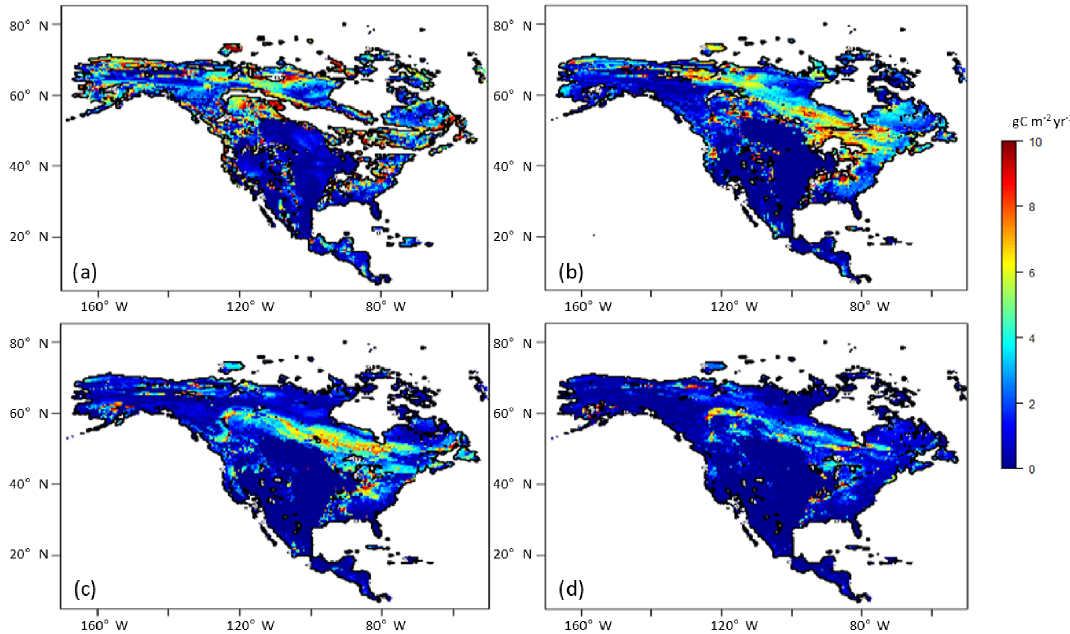
Figure 3. Simulated NEP (gCm − 2 yr − 1 ) with the original spin-up method after different spin-up times of (a) 50, (b) 100, (c) 150 and (d) 200 years. After these spin-up times, 63, 89, 93 and 98% of grids reach their steady states, respectively.